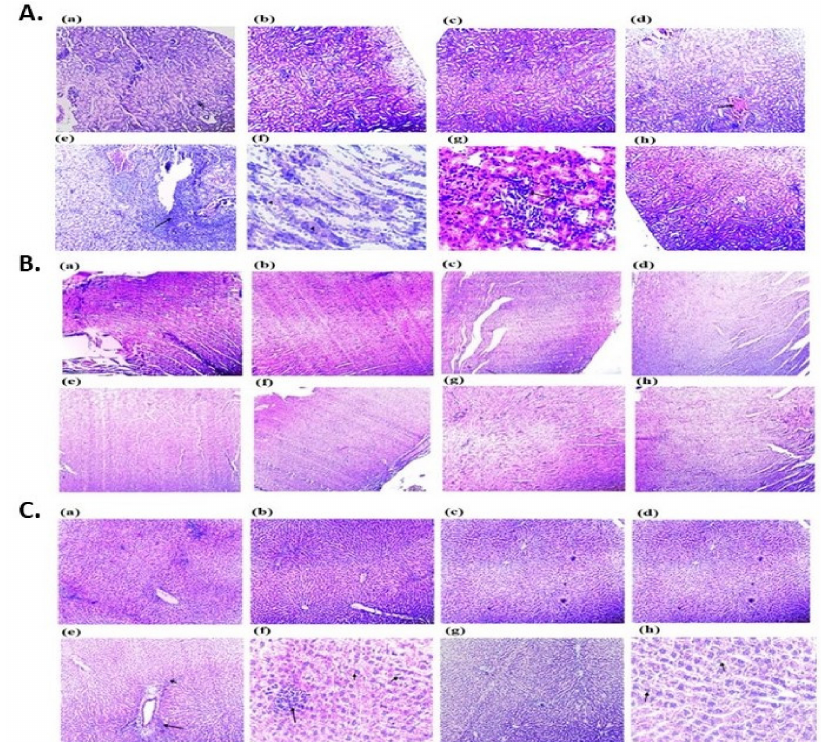
Figure 5. Photomicrographs of; ( A ). Kidney ( B ). Heart ( C ). Liver, section of rats from different groups following 28 days repeated oral exposure to biosynthesized ZnO NPsAL. ( a ) Control group ( b ) 0.01 M